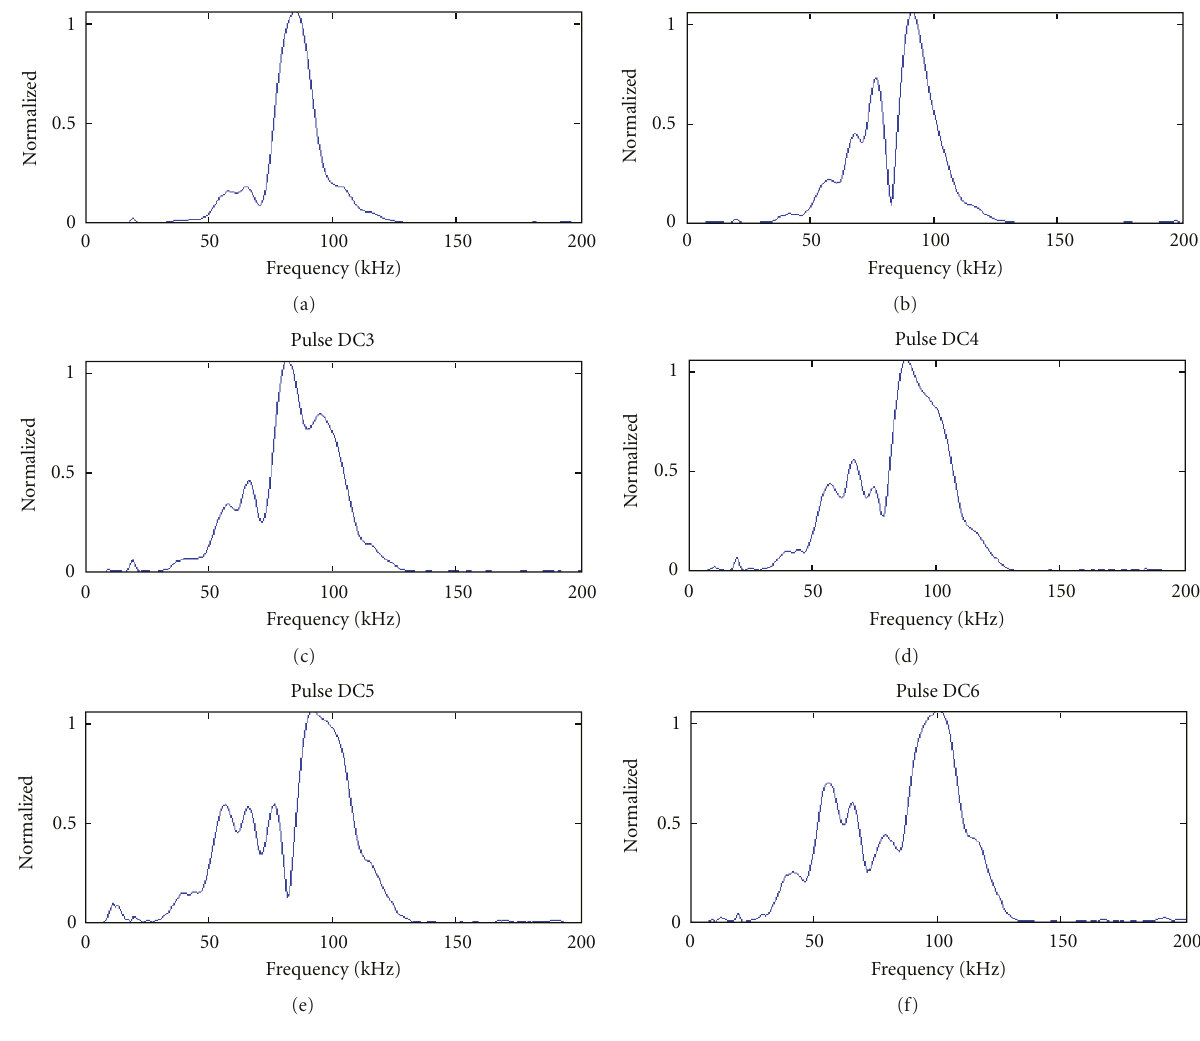
Figure 23: Spectral responses for cable type C, pulses